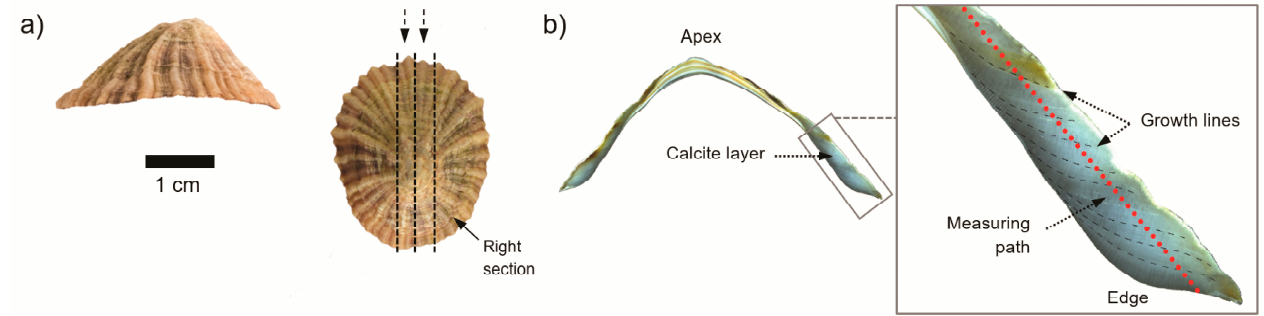
Figure 3. ( a ) Modern specimen of Patella depressa . Dashed lines indicate the cutting axis from which two thick sections were obtained. Dashed arrows show the two thick sections previously used for conducting a sclerochronological study on these shells. The remaining right-hand limpet section was used for elemental analyses carried out using LIBS. ( b ) Limpet cross-section showing the calcite layer and portion of the cross-section showing the visible growth lines. Red points indicate the LIBS measuring path.